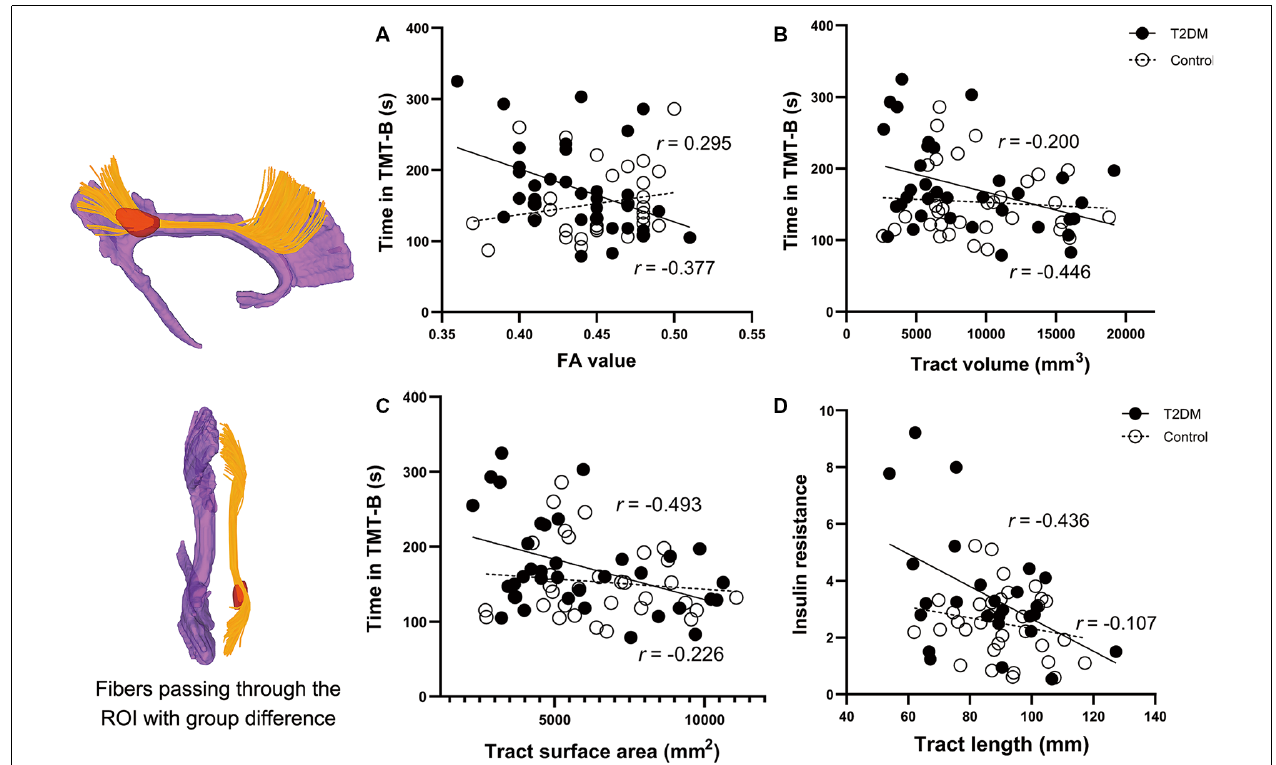
FIGURE 4 | Correlations between the clinical parameters and the diffusion measures of the reconstructed tract using ROI-based tractography. Figures on the left are the results of the voxel-wise comparison of FA maps between the two groups. Significantly decreased FA was found in the posterior part of the right cingulum (the region in red). The tract passing through the ROI is illustrated in yellow. Correlations in the T2DM group are presented in black circles, while correlations in the control group are presented in white circles. (A–C) In the T2DM group, the time spent in TMT-B was negatively correlated with FA, volume, and surface area of the tract. (D) IR in the T2DM group was negatively correlated with the mean length of the reconstructed tract. No such correlations were observed in the control group. The CB shown in purple was derived from the template HCP1021-1mm (https://pitt.app.box.com/v/HCP1021-1mm). CFT-delay, complex figure test-delay trial; TMT-B, trail making test-part B; IR, insulin resistance; FA, fractional anisotropy; ROI, the region of interest.